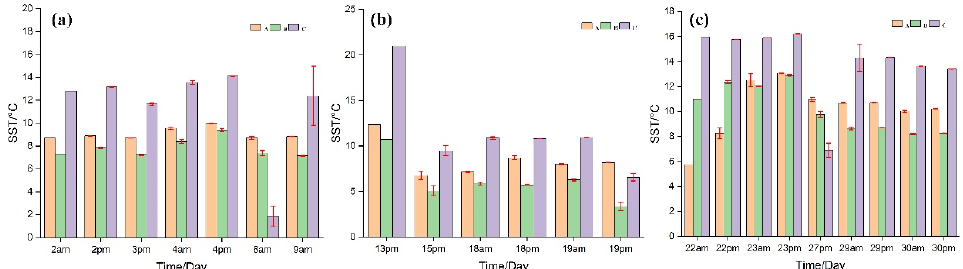
Figure 6. Changes in the SST of the Yangtze Estuary during the cold wave (where ( a – c ) represent the cold wave in January 2015, the cold wave in January 2021, and the cold wave in December 2021, the horizontal coordinates represent the date, am is morning, pm is afternoon, and the length of the red error bars represent the magnitude of the temperature change).